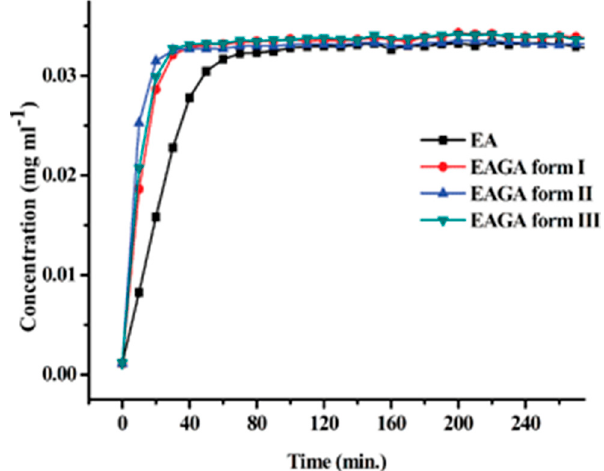
Figure 22. Dissolution profile of EA-GA cocrystal polymorphs I, II, and III compared to pure drug EA. Adapted with permission from CrystEngComm , 2009, 11, 1823–1827. Copyright 2009, The Royal Society of Chemistry.